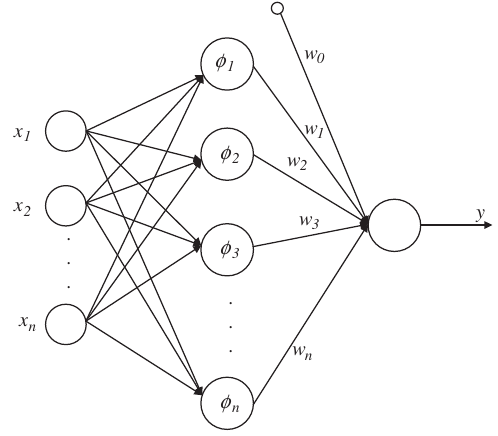
Fig. 7. Schematic of RBF neural